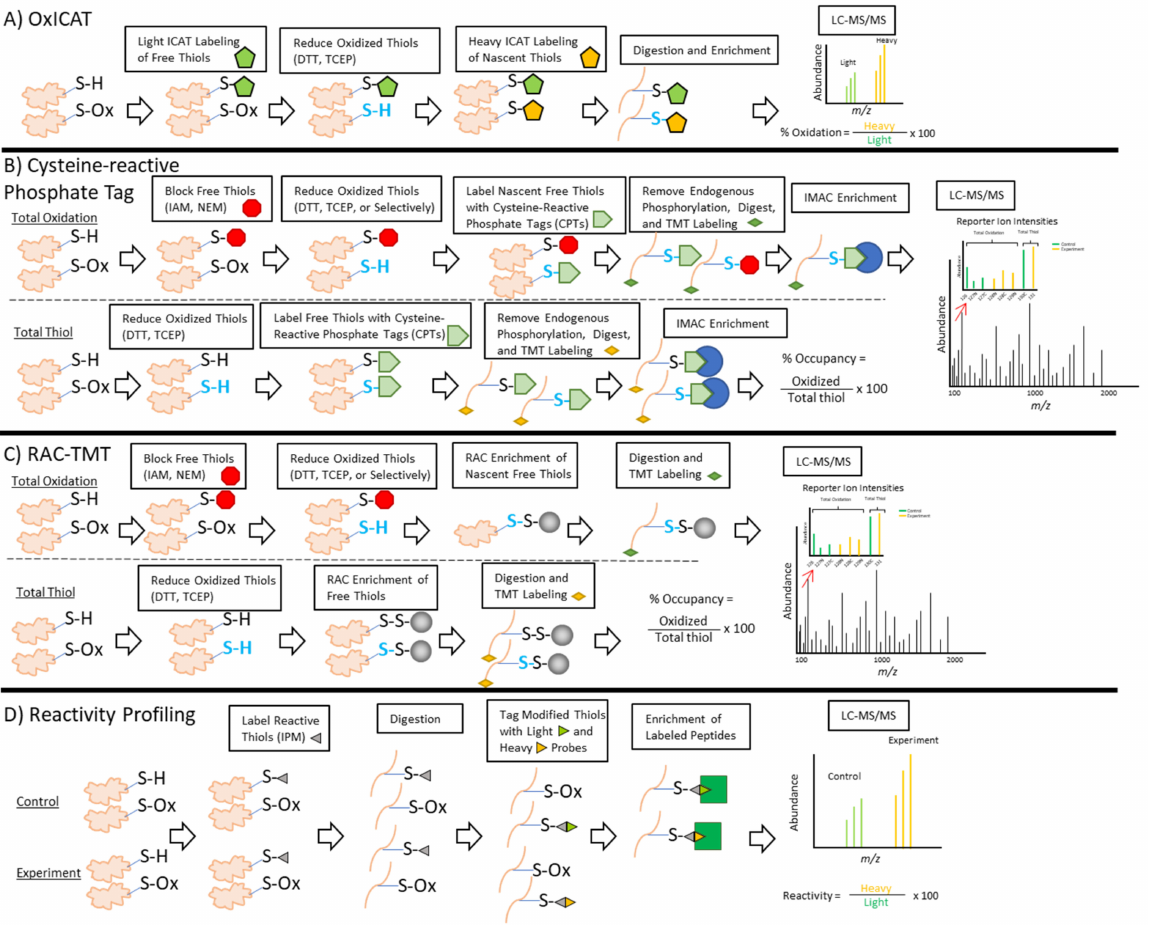
Figure 5. Simplified schematics of different quantitative redox proteomics approaches. Each schematic uses two proteins per scenario to represent the reduced (S-H) and oxidized (S-Ox) forms. Oxidized thiols represent any variety of reversible thiol modifications shown in Figure 1. Blue reduced thiol groups represent the formation of nascent free thiols following the reduction of oxidized thiols. In the cysteine-reactive phosphate tag and RAC (resin assisted capture) methods, total thiol samples are included as a separate reference channel for stoichiometric measurements (i.e., total thiol, representing all detectable thiols). Measurements are based on reporter ion intensities. ( A ) Labeling reduced and oxidized cysteines with isotope coded affinity tags (OxICAT). Free thiols are irreversibly labeled with isotopically light ICAT, followed by the reduction of oxidized thiols to free thiols that are labeled with isotopically heavy ICAT. Labeled proteins are then digested and enriched by streptavidin beads via the biotin group on the ICAT reagents. The enriched peptides are released by the cleavage of the biotin moiety and analyzed by mass spectrometry. The modification stoichiometry is determined by the ratio of a peptide’s corresponding heavy and light peptide intensities. ( B ) Free thiols are initially alkylated, and then removed to avoid the recovery of phosphorylated peptides during immobilized metal affinity chromatography